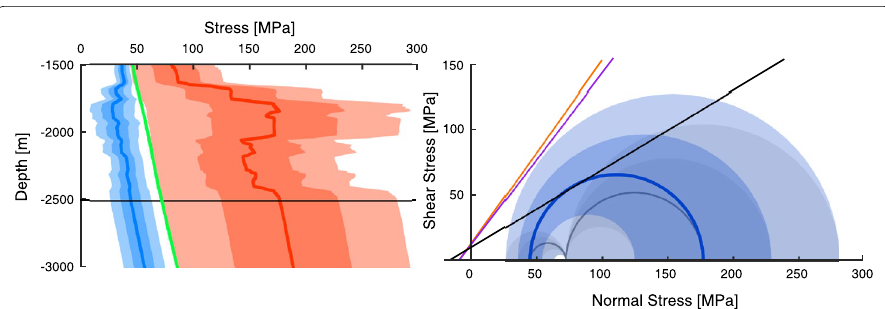
Fig. 9 Modelled stress state at the geothermal project Poing where seismicity up to Ml 2.1 has been recorded. The left panel shows a depth vs. stress plot with S Hmax (red), S v (green), and S hmin (blue). The average values are the bold lines, a standard deviation of one sigma (strongly shaded) and two sigma (lightly shaded, approximately 95% probability of the stress state to be within these bounds) is shown for S Hmax and S hmin . The target depth at 2503 m below sealevel is indicated by the bold black horizontal line. The right panel − shows a Mohr–Coulomb diagram at target depth. The differential Mohr circle ( S 1 – S 3 ) is indicated in blue and S 1 – S 2 and S 2 – S 3 are indicated in grey. The averages are indicated by bold lines, the standard deviation of one sigma by a strong shaded area and of two sigma by a lightly shaded area. A standard failure envelope (black) is included for reference with a friction coefficient of µ 0.6 and a cohesion of C 10 MPa. Failure envelopes = = for Malm dolomite (orange, C